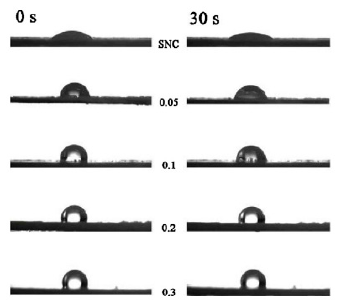
Figure 12. Photographs of a water drop on the surface of SNC and silylated SNC. Adapted from [60], with permission from Elsevier and Copyright Clearance Center, 2016.